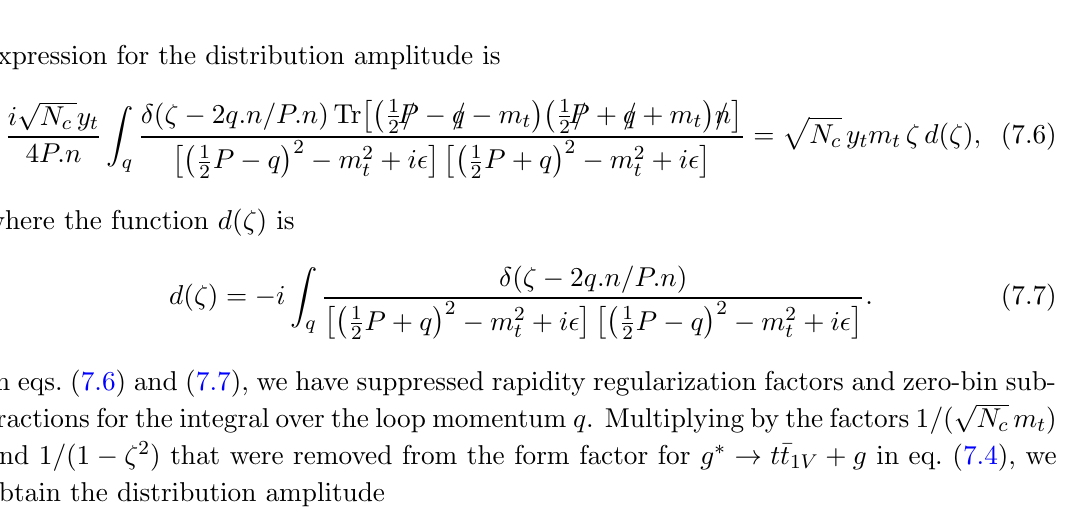
Figure 4 . Feynman diagram for the distribution amplitude for t (cid:22) t 1 V ! H at